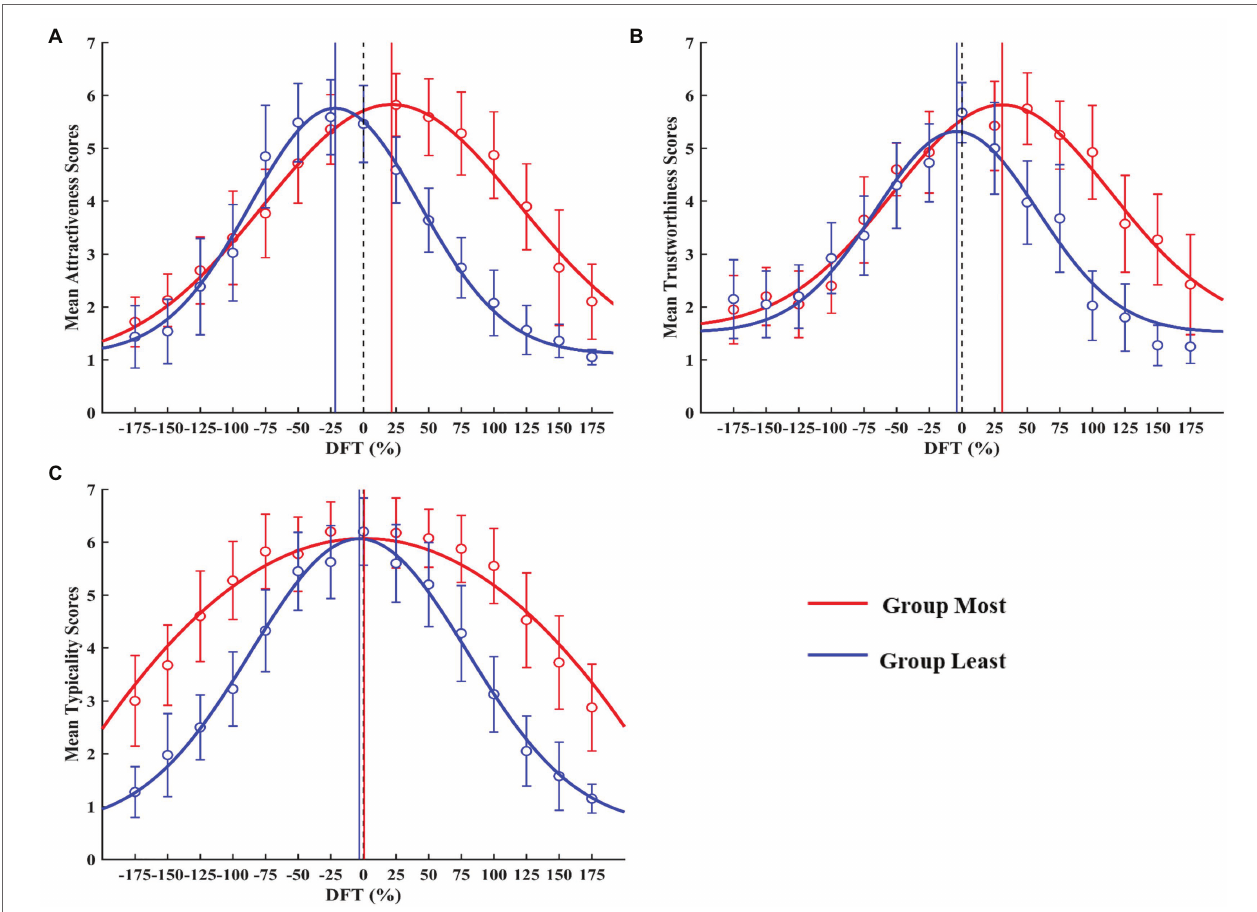
FIGURE 4 | Mean trait judgments as a function of DFT based on Group Most/Least face continua: (A) attractiveness, (B) trustworthiness, and (C) typicality. Black dotted line represents the location of the average face (DFT = 0%). Solid lines represent locations of predicted DFT for peaks for Group Most (red) and Group Least (blue). Error bars represent 95% confidence intervals.